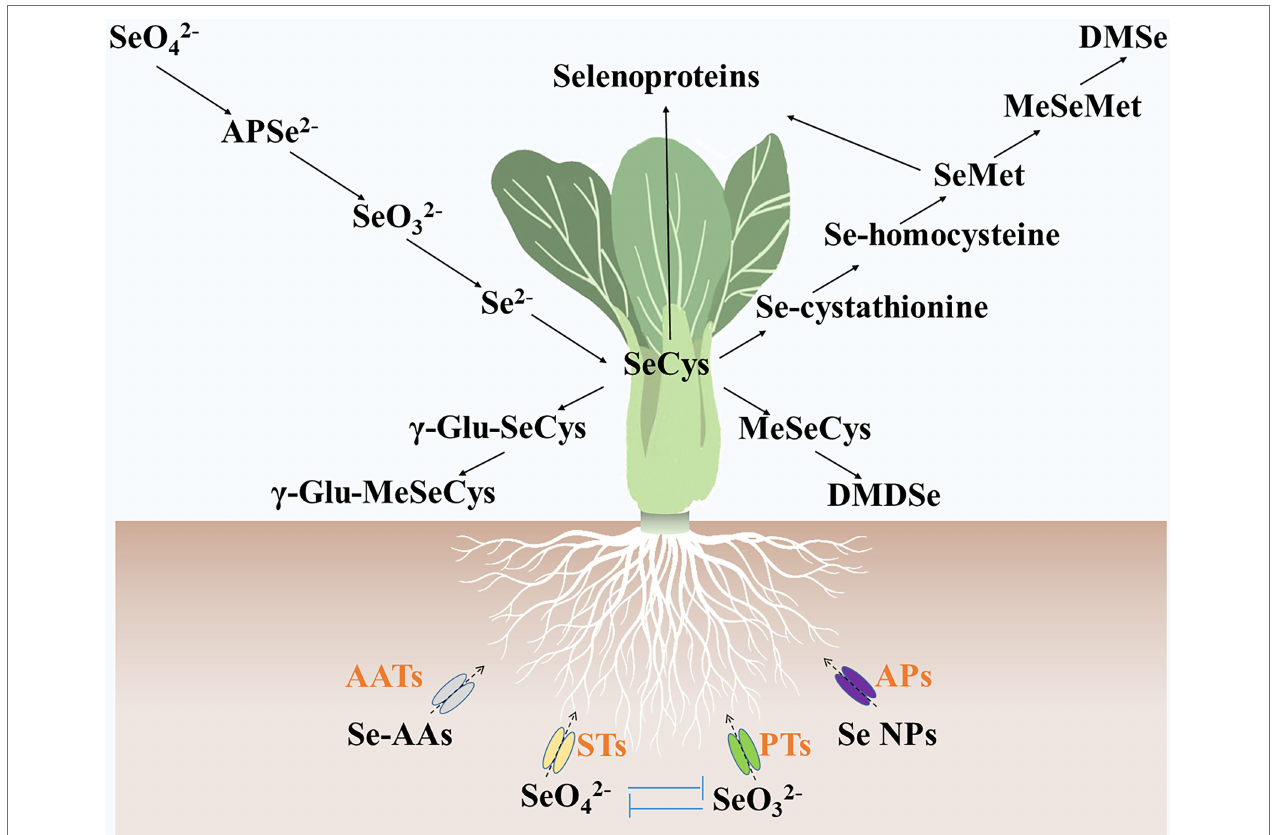
FIGURE 2 | Metabolic fate of selenium in vegetables. Se-AAs, selenate, selenite, and Se nanoparticles are absorbed by vegetables via amino acid transporters, sulfate transporters, phosphate transporters, and aquaporins, respectively. Then, these selenium forms were assimilated into various selenium metabolites, such as adenosine phosphoselenate, SeCys, γ -glutamyl-selenocysteine, γ -Glu-MeSeCys, MeSeCys, Se-cystathionine, Se-homocysteine, SeMet, Se- methylselenomethionine, dimethyldiselenide, dimethylselenide, and selenoproteins. AATs, amino acid transporters; APs, aquaporins; PTs, phosphate transporters; and STs, sulfate transporters. SeO 32 − , Selenite; APSe 2 − , adenosine phosphoselenate; SeO 42 − , selenate; Se NPs, Se nanoparticles; γ -Glu-SeCys, γ -glutamyl- selenocysteine; MeSeMet, Se-methylselenomethionine; DMDSe, dimethyldiselenide; and DMSe,